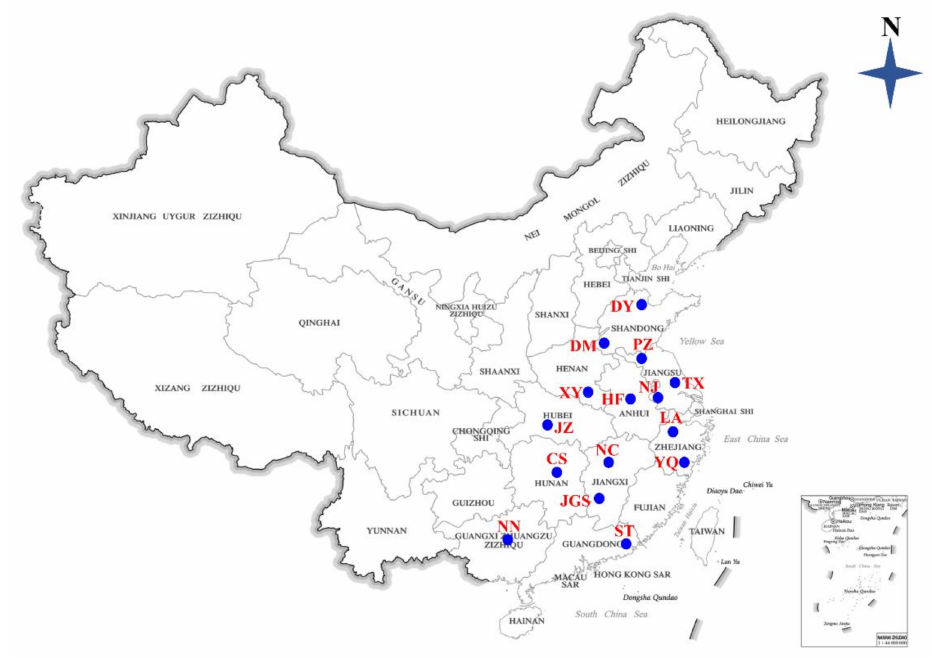
Figure 1. Distribution map of M. azedarach seed collection sites. The blue dots indicated the lo- cations sampled. DY: Dongying, Shandong Province; DM: Dongming, Shandong Province; PZ: Pizhou, Jiangsu Province; TX: Taixing, Jiangsu Province; NJ: Nanjing, Jiangsu Province; HF: Hefei, Anhui Province; XY: Xinyang, Henan Province; NC: Nanchang, Jiangxi Province; JGS: Jinggang- shan, Jiangxi Province; CS: Changsha, Hunan Province; JZ: Jingzhou, Hubei Province; LA: Linan, Zhejiang Province; YQ: Yueqing, Zhejiang Province; ST: Shantou, Guangdong Province; NN: Nanning, Guangxi